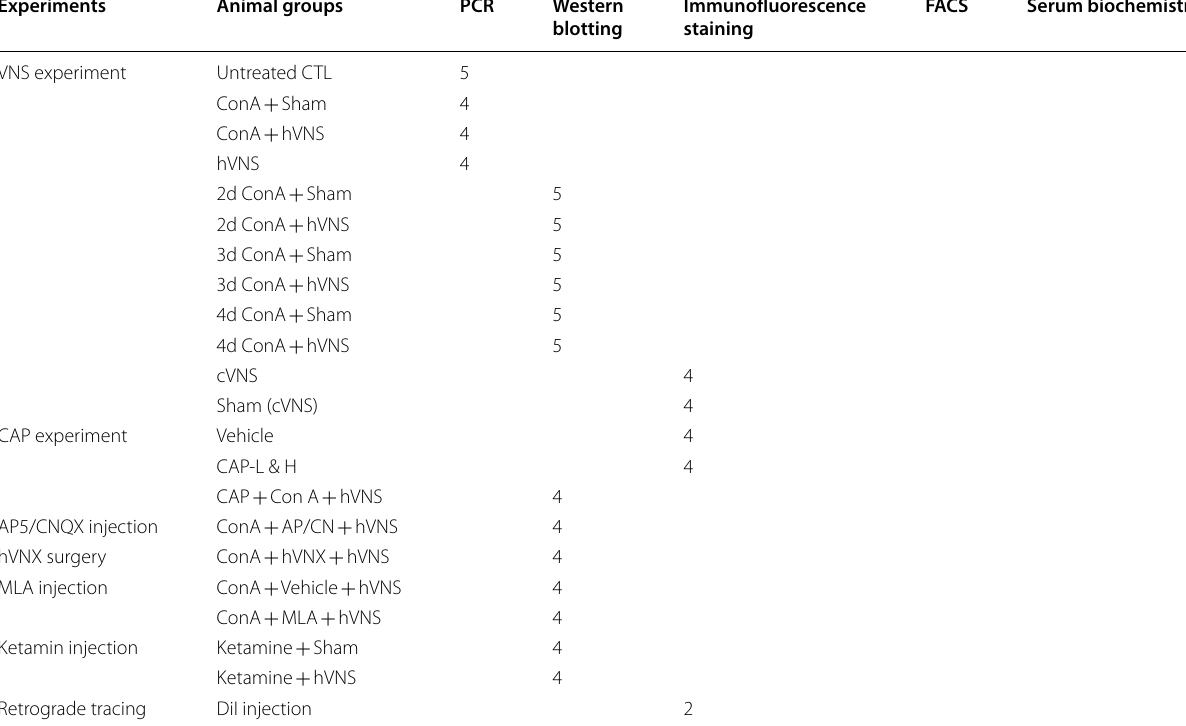
Table 1 Number of animals and experimental groups